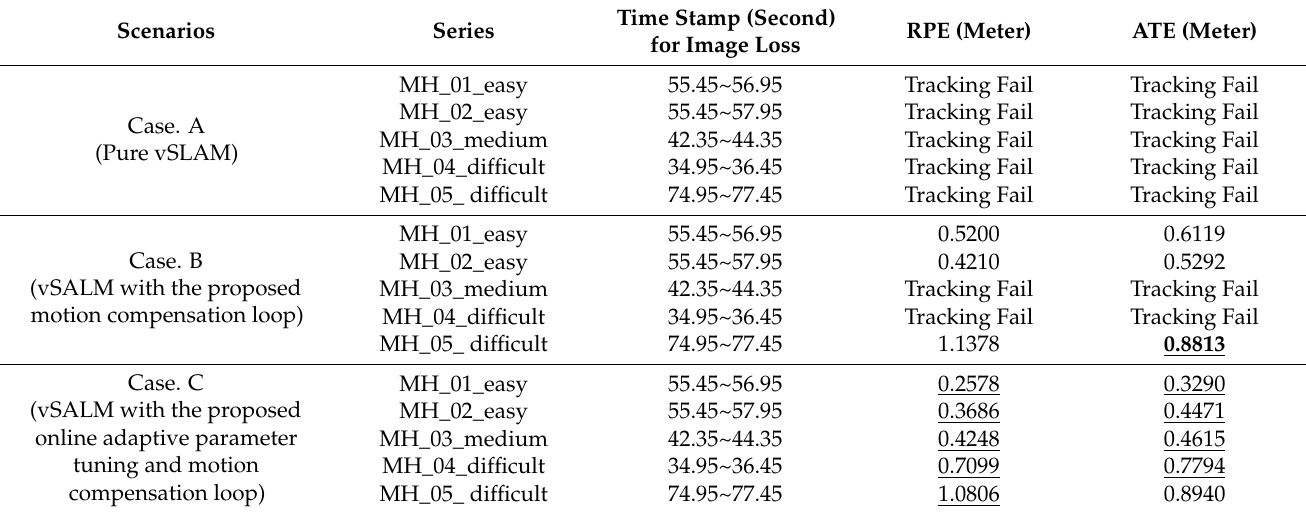
Table 7. Results of anti-shading robustness